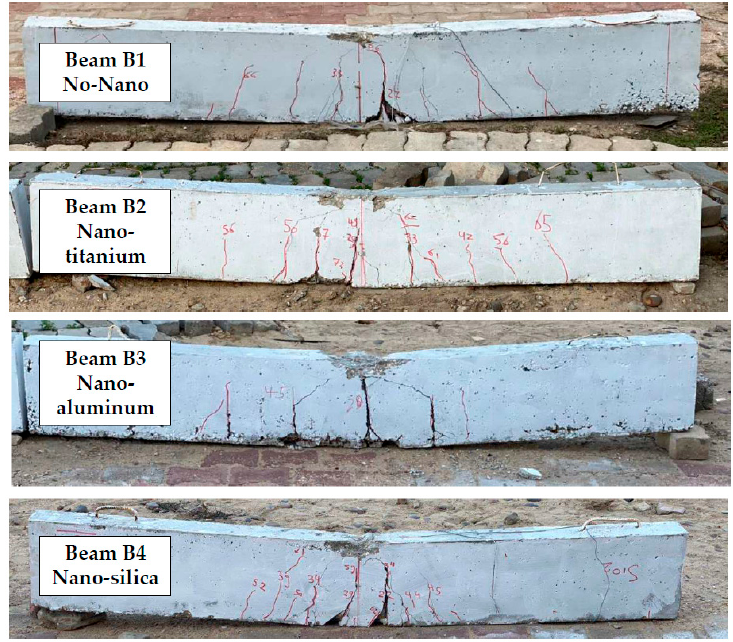
Figure 4. Failure modes of the tested RC beams subjected to monotonic loading.